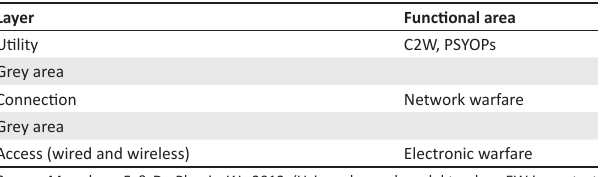
TABLE 1: Proposed Layer Model for